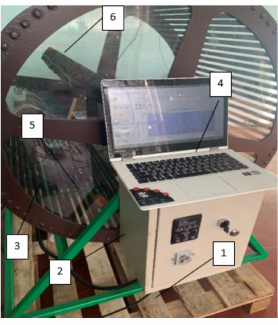
Figure 5. A general view of the laboratory installation for assessing the force effect of a mock-up sample of a device for assessing the suitability of varieties and hybrids for mechanized harvesting: 1—a support platform; 2—a control cabinet; 3—a drum; 4—a personal computer; 5—a data recorder; 6—a finger